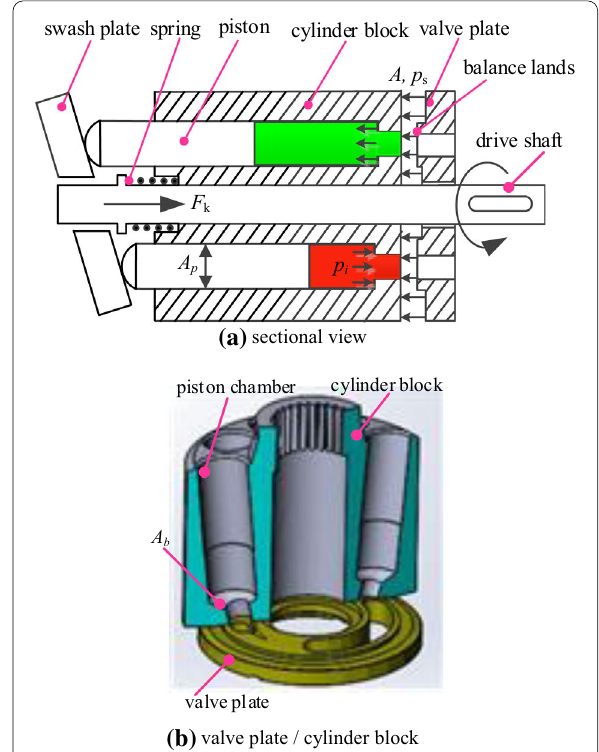
Figure 1 Sketch of the valve plate/cylinder block within the axial piston